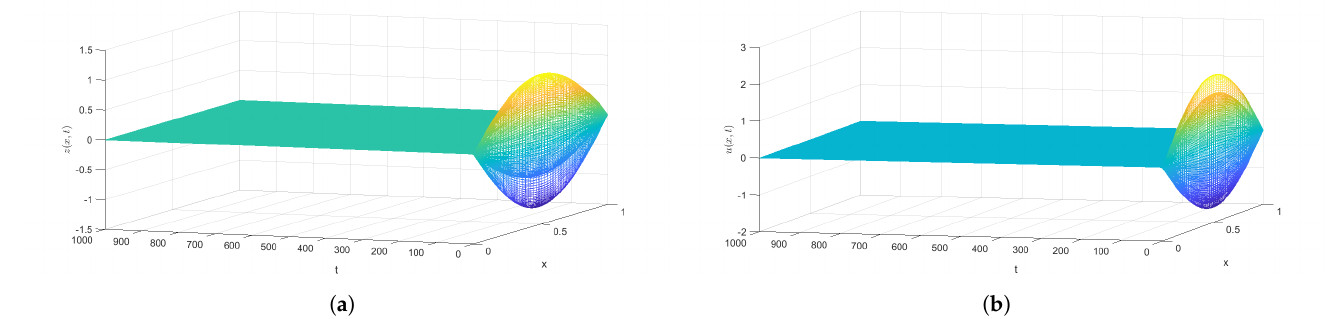
Figure 1. Test 1: The approximate solution ( z , u ) in the x - t plane. ( a ) z ( x , t ) . ( b ) u ( x , t )